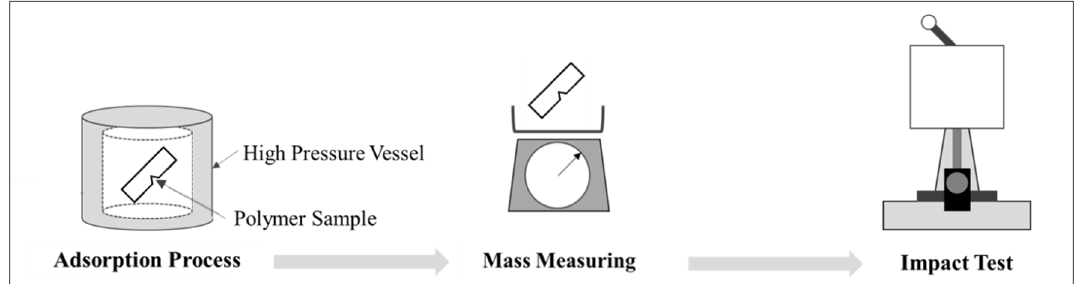
Figure 4. Experimental process for studying changes in impact strength through CO 2 adsorption.